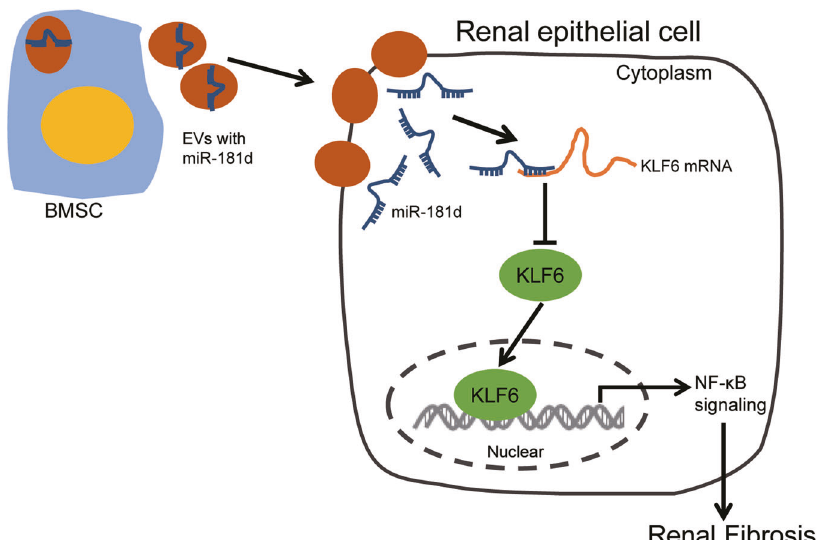
Fig. 6 Effects of bone marrow mesenchymal stem cell-derived extracellular vesicles on renal fi brosis by regulating miR-181d/KLF6/NF- κ B axis. Note: A diagram showing the mechanism whereby miR-181d is transferred by BMSC-EVs into neighboring cells where it targets KLF6, thereby inactivating the NF- κ B signaling pathway and alleviating renal fi brosis in